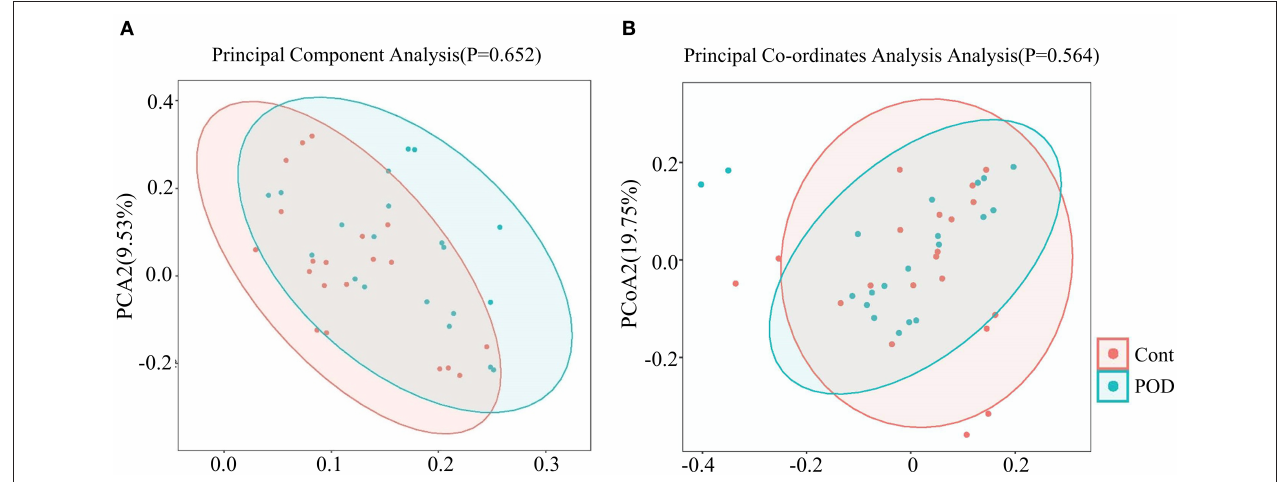
FIGURE 2 | β -diversity analyses of data. (A) Principal component analysis (PCA). (B) Principal Co-ordinates Analysis